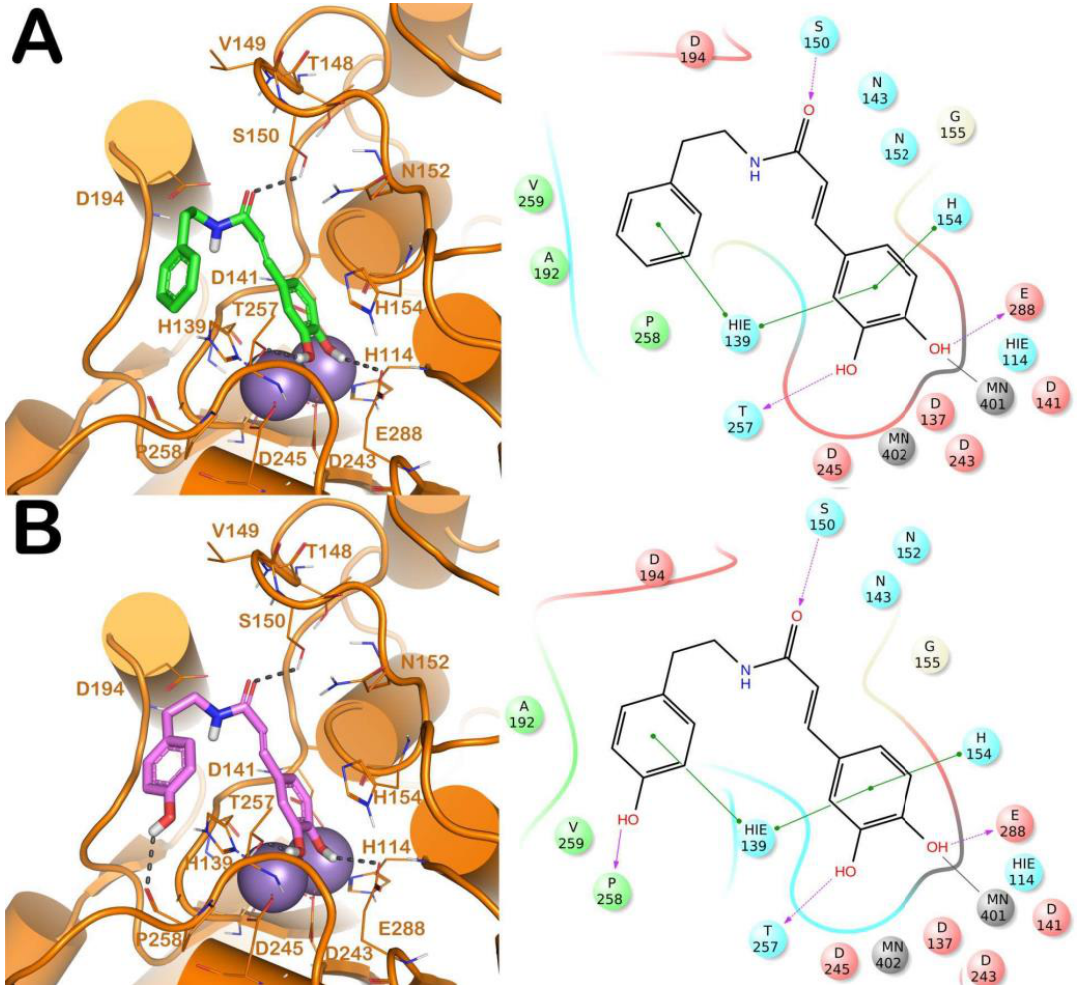
Figure 1. ( A ) Putative binding mode of CAPA (green sticks) into L-ARG binding site (PDB ID 4IU1; orange cartoon) as found by Glide software. Metals are represented as gray spheres. Key residues of the binding site are represented by lines. H-bonds are represented as black dotted lines, while the metal coordination bonds are represented by colored dotted lines. The ligand interaction diagram is reported on the right panel. ( B ) Putative binding mode of compound 6 (pink sticks) into L-ARG binding site (PDB ID 4IU1; orange cartoon) as found by Glide software. Metals are represented as gray spheres. Key residues of the binding site are represented by lines. H-bonds are represented as black dotted lines, while the metal coordination bonds are represented by colored dotted lines. The picture was generated by PyMOL (The PyMOL Molecular Graphics System, v1.8; Schrodinger, LLC, New York, NY, USA, 2015), while the ligand interaction diagram was generated by Maestro (Maestro, Schrödinger, LLC, New York, NY, USA, 2016).